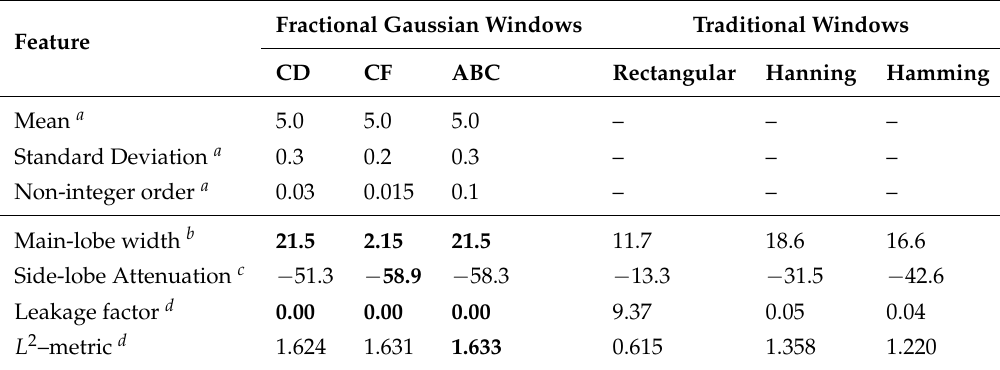
Table 3. Summary of results obtained from all the methodologies studied in this